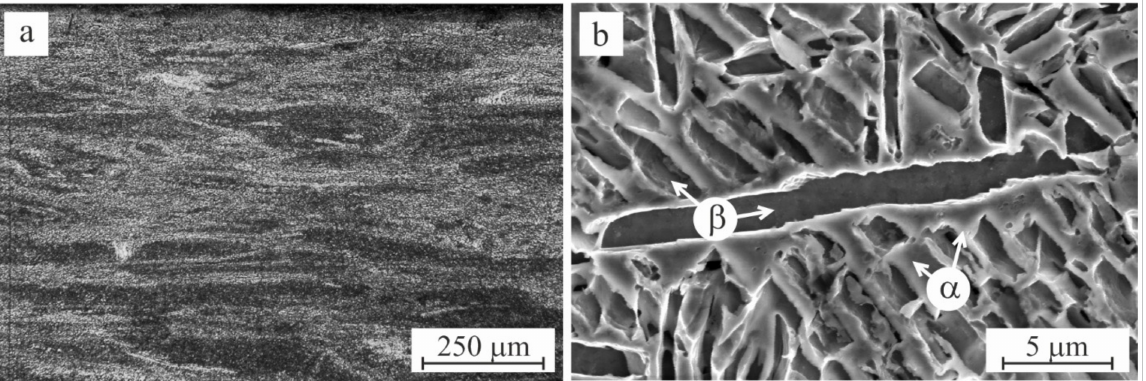
Figure 2. Metal structure of as-received samples of α + β titanium alloy (series 1); ( a ) surface layer; ( b ) α - and β